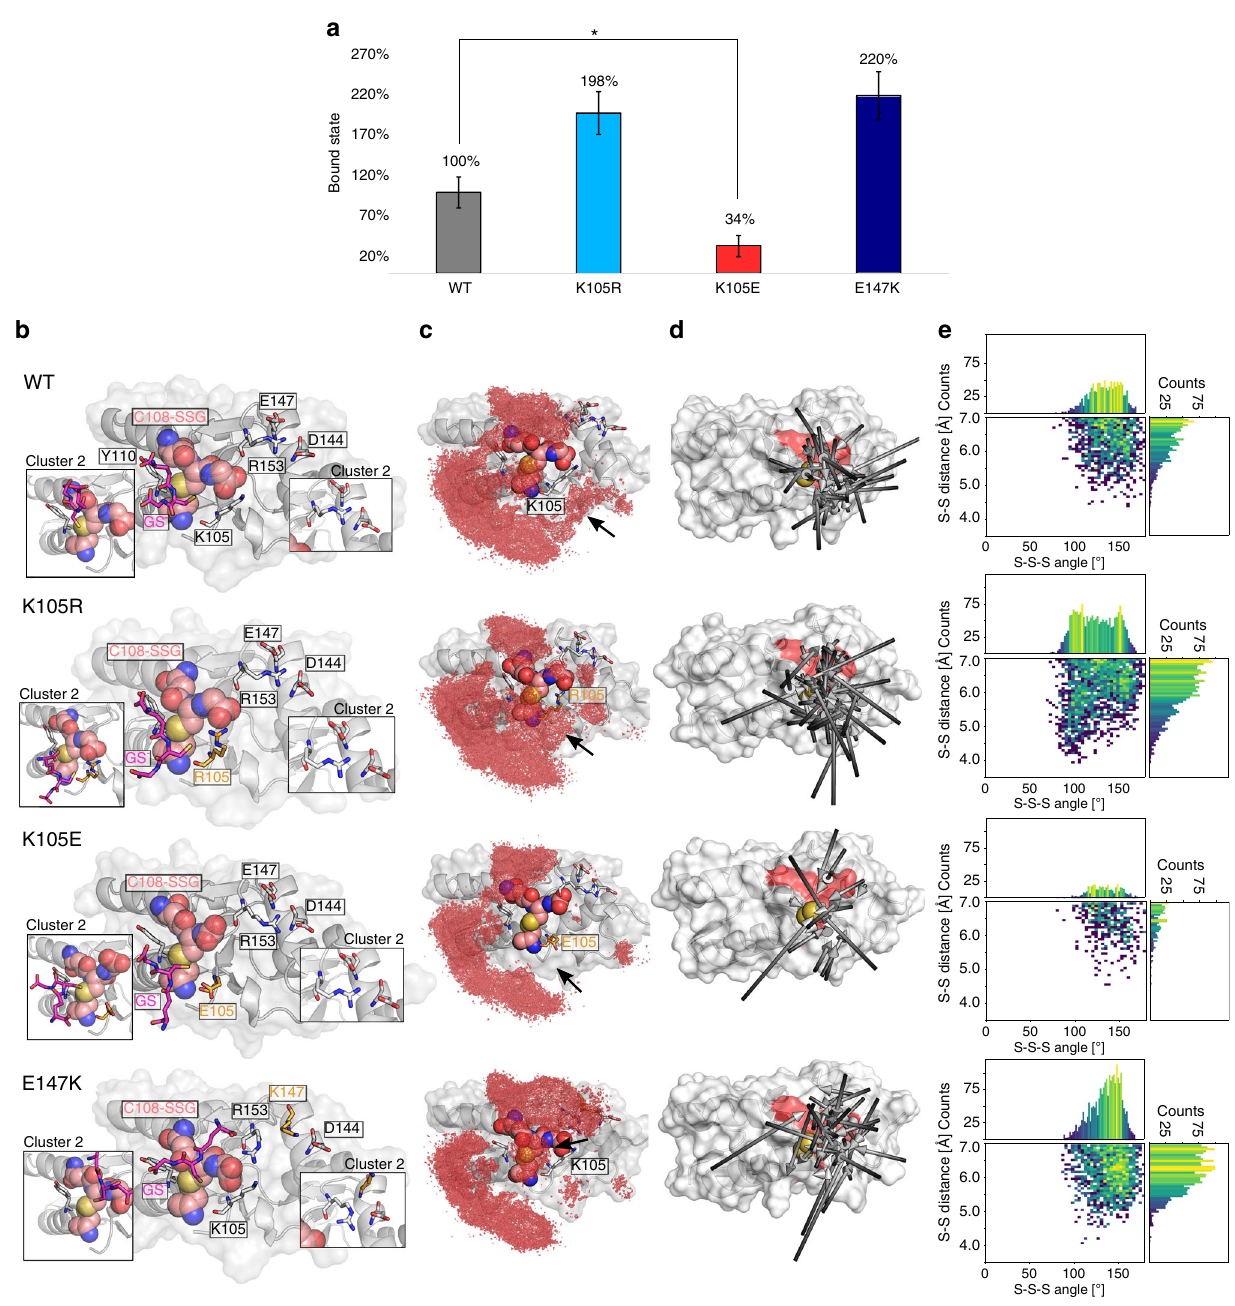
Fig. 8 Molecular dynamics simulations of GS − binding to glutathionylated ScGrx7. a Fraction of bound states with the value for wild-type ScGrx7 (WT) normalized to 100%. Error bars show the standard error of the mean over four replications for each system. Datasets were tested with a two-tailed t test assuming unequal variances; *: null-hypothesis of equal means can be rejected with P < 0.05. For WT and K105R P = 0.13; for WT and E147K P = 0.15 (see also Supplementary Table 13). b For each of the systems of the WT and the variants K105R, K105E, and E147K, bound states were clustered with respect to the structural deviation of the active site and the closest GS − from the solution. The structure representing the most populated cluster is shown in the middle and important areas of the structure representing the second most populated cluster (cluster 2) are shown in the boxes next to it. The covalently bound glutathione moiety at Cys108 is depicted in salmon, the freely diffusing GS − in pink. Residues marked in orange show the mutated residues in the variants. All residues with labels were also studied experimentally. c The occupation density of the diffusing GS − is shown as a red grid on the structure of each ScGrx7 variant. Bound states were combined across replications for this analysis, and the threshold of the density grids is the same for all variants. d Arrows show the binding pathways of GS − . For each binding event, an arrow shows the linearized trajectory of the GS − molecule right before the binding event going from black (start of the pathway) to gray (bound). The active site is shown as a red surface and the sulfur atoms of the mixed disul fi de bond are shown in yellow. e Histograms show the distance between the sulfur atom of GS − and the center of mass of the sulfur atoms of Cys108-SSG ( “ S – S-distance ” ) and the angle created by the three sulfur atoms ( “ S – S – S angle ” ) over all four replications each. The color of the bins ranges from dark blue (lowest populated bin) over green to yellow (highest populated bin). See Supplementary Table 14 for results of the correlation